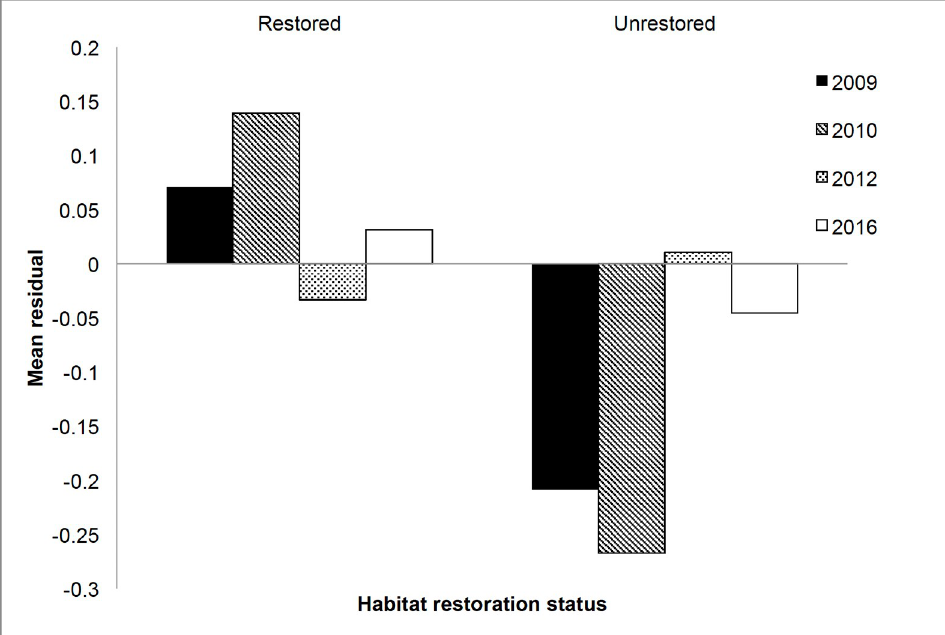
Fig 8. Mean residuals from a log-linear regression of growth rate versus size, in restored vs. unrestored habitat, for each study year. The analysis omits 2013 owing to lack of long-term steelhead recaptures in unrestored habitats.